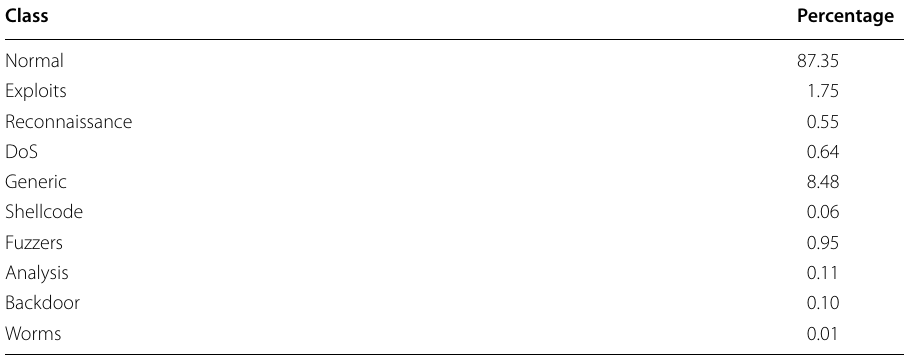
Table 2 Class distribution in full